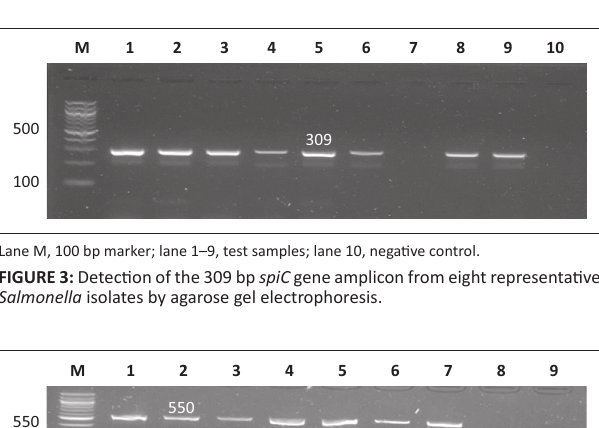
FIGURE 2: Detection of the 606 bp iroB gene amplicon from nine representative Salmonella isolates by agarose gel